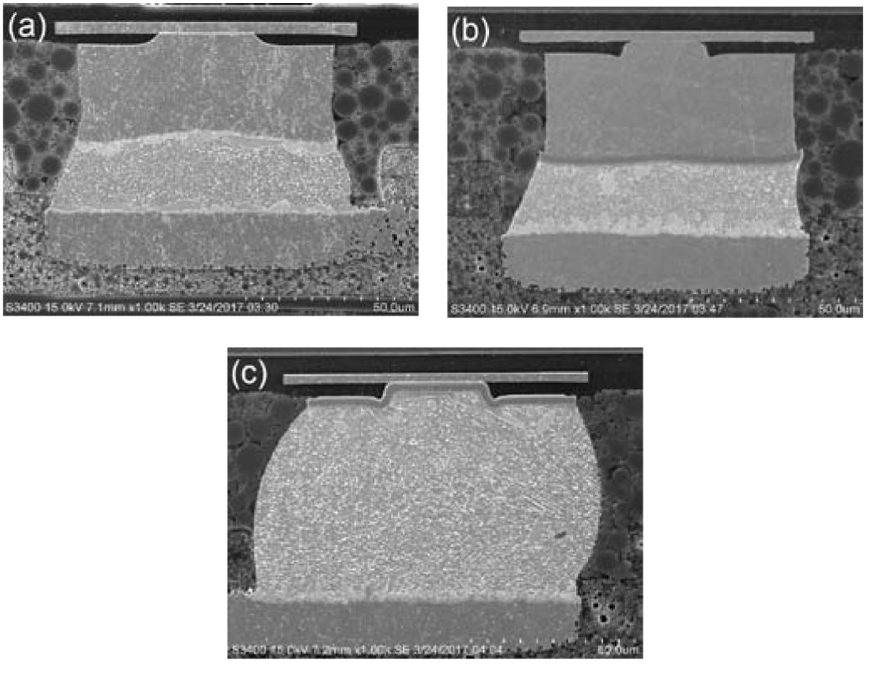
Figure 4. Cross-section of